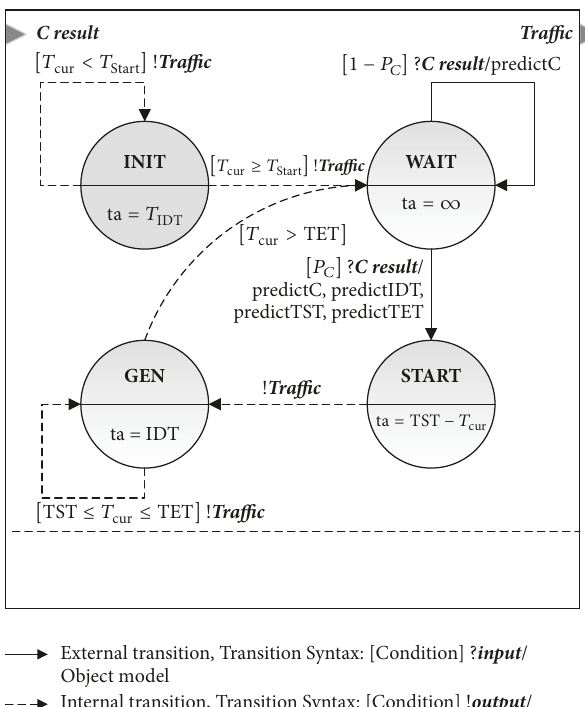
Figure 7: Traffic model design using the DEVS formalism.